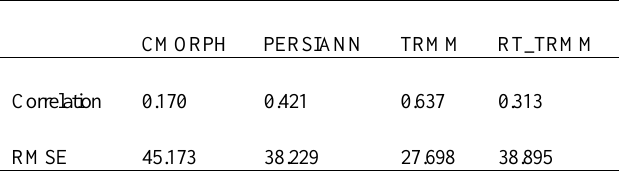
Table 2: The values of the efficacy criteria for comparing